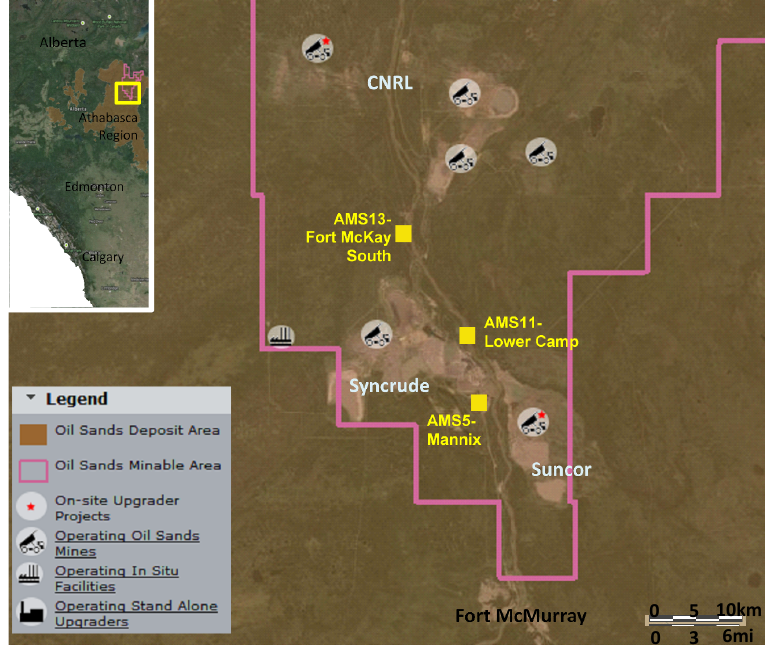
Figure 1. Locations of the various extraction processes and three measurement sites (triangles) within the municipality of Wood Buffalo in the Athabasca region of Alberta, Canada. Map courtesy of Alberta’s Environmental and Sustainable Resource Development. Available at